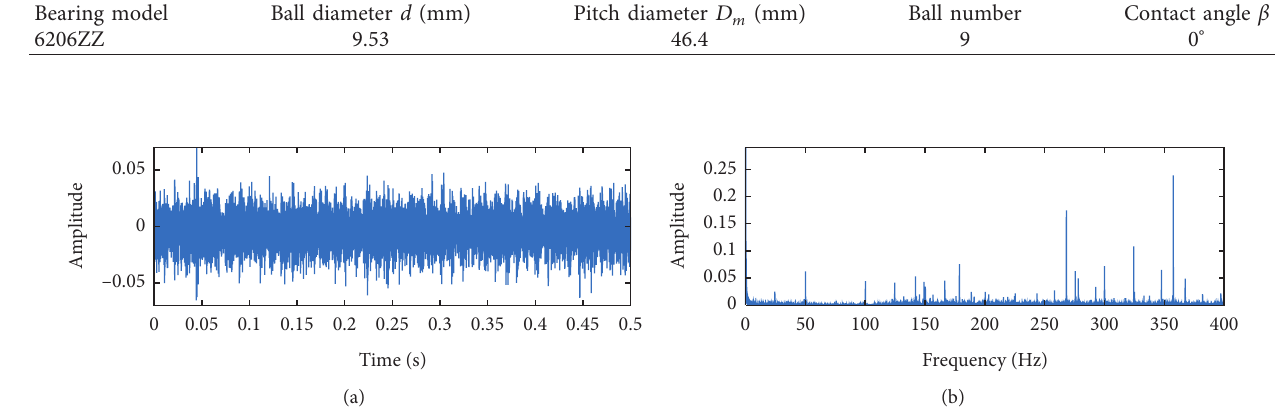
Figure 11: Vibration signal of experimental bearing. (a) Waveform. (b) Spectrum.